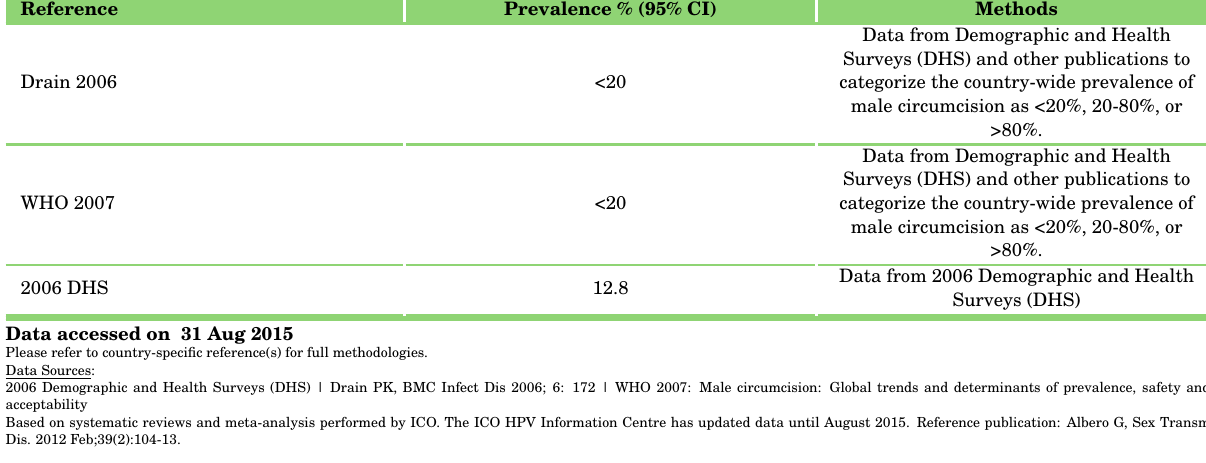
Table 47: Prevalence of male circumcision in India